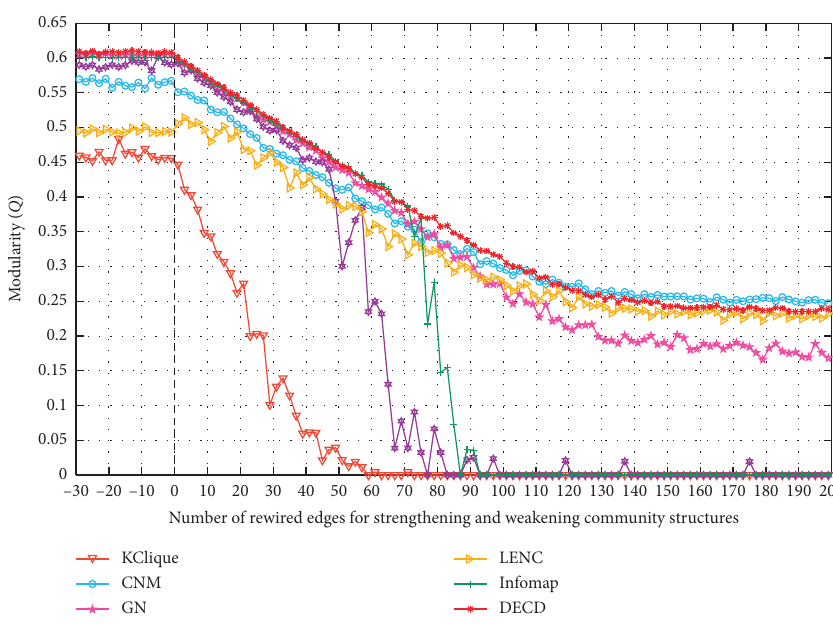
Figure 4: The average optimal value of Q obtained by typical community detection algorithms on a set of benchmarks with gradually modified community intensity, which are generated based on the American College Football (ACF) network. Each data point is obtained based on averaging 10 independent runs of each algorithm on each benchmark. The negative and positive values of the abscissa represent the number of rewired edges when the community structure is strengthened and weakened, respectively.